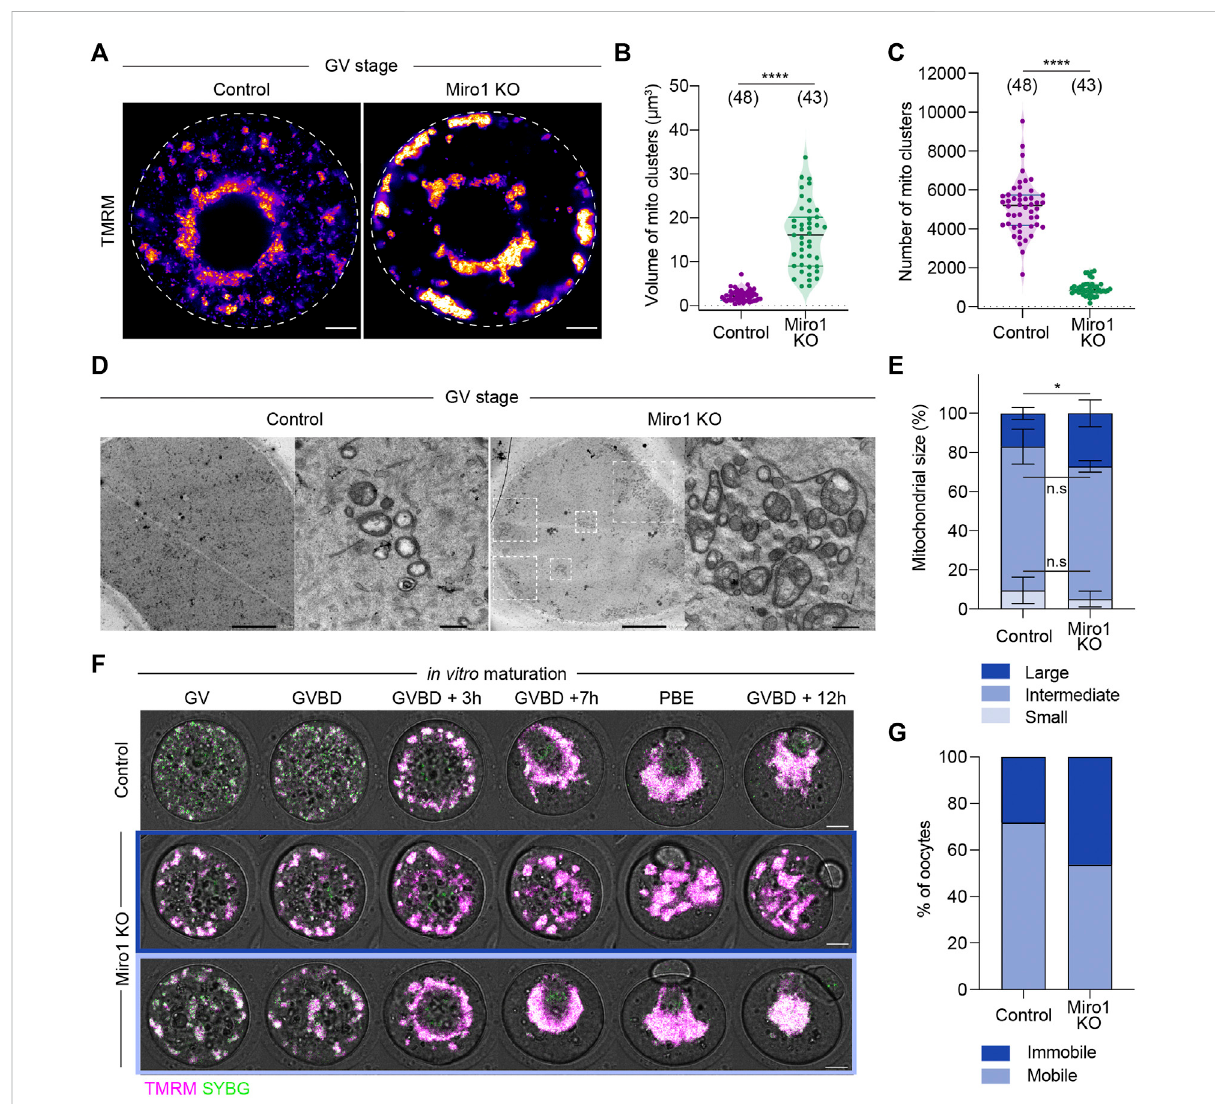
Deletion of Miro1 alters mitochondrial localization and mitochondrial ultrastructure. (A) Representative images of mitochondrial localization in GV-stage control and Miro1 KO. Fire: TMRM. Scale bar: 10 µm. (B,C) Comparison of volume and number of mitochondrial clusters in control and Miro1 KO. Unpaired t -test **** p < 0.0001. Data are collated from 3 independent experimental replicates (D) TEM images of whole oocytes and high magni fi ed mitochondria in control and Miro1 KO. Dashed square: Mitochondrial aggregates. Scale bar of whole oocyte image: 10 μ m, magni fi ed: 500 nm. (E) Semi-quanti fi cation analysis of individual mitochondria observed in TEM images. Control ( n = 455) or Miro1 KO ( n = 608). One-way ANOVA followed by Wilcoxon signed-rank test. * p < 0.05. Data are collated from 3-4 independent experimental replicates and presented as mean ± SD (F) Time-lapse images of maturing control and Miro1 KO. Magenta: TMRM, Green: Sybr Green. Scale bar: 15 µm. (G) Percentage of control ( n = 39) or Miro1 KO ( n = 41) having mobile or immobile mitochondria. Chi-square test, n.s., not signi fi cant, p = 0.09. Data are collated from 3 independent experimental